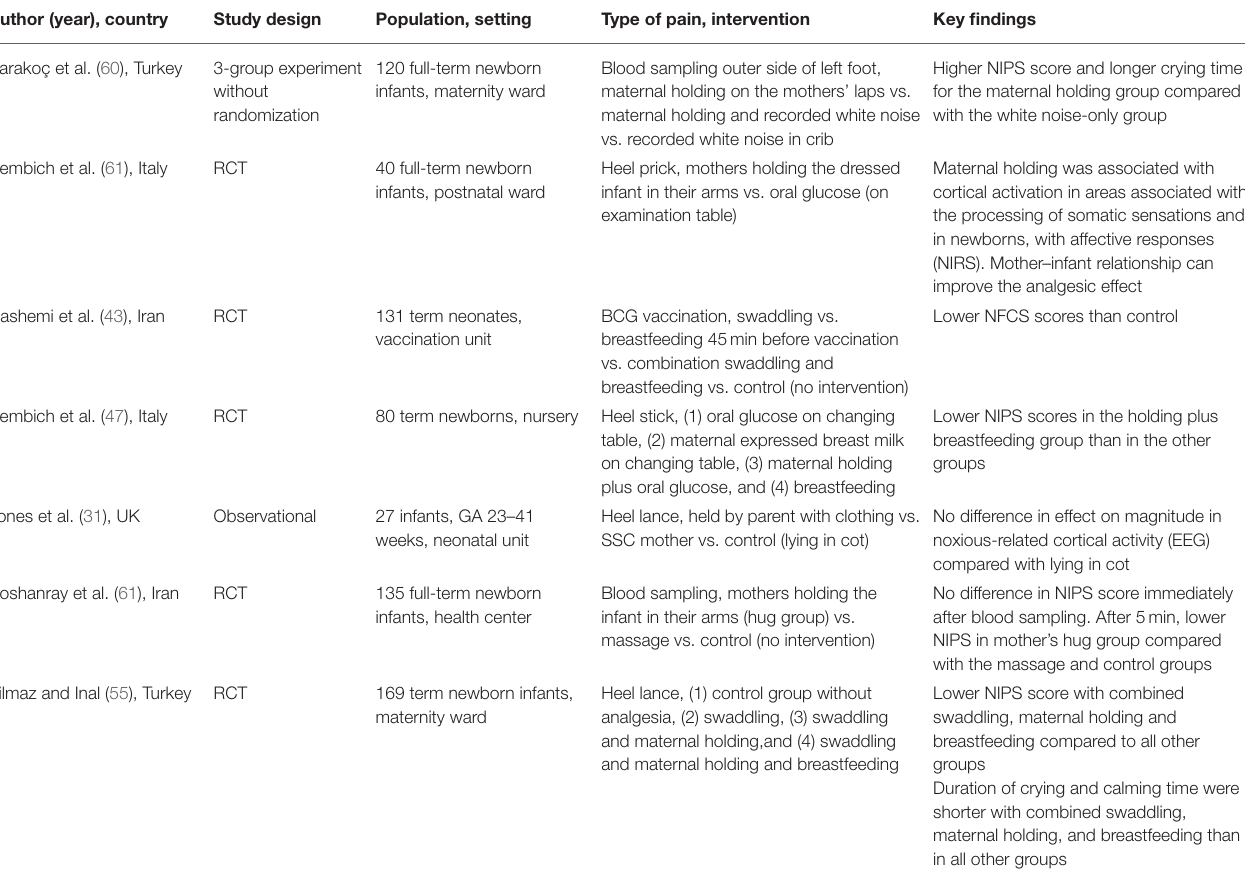
TABLE 4 | Evidence for parent-delivered interventions: holding or swaddling.